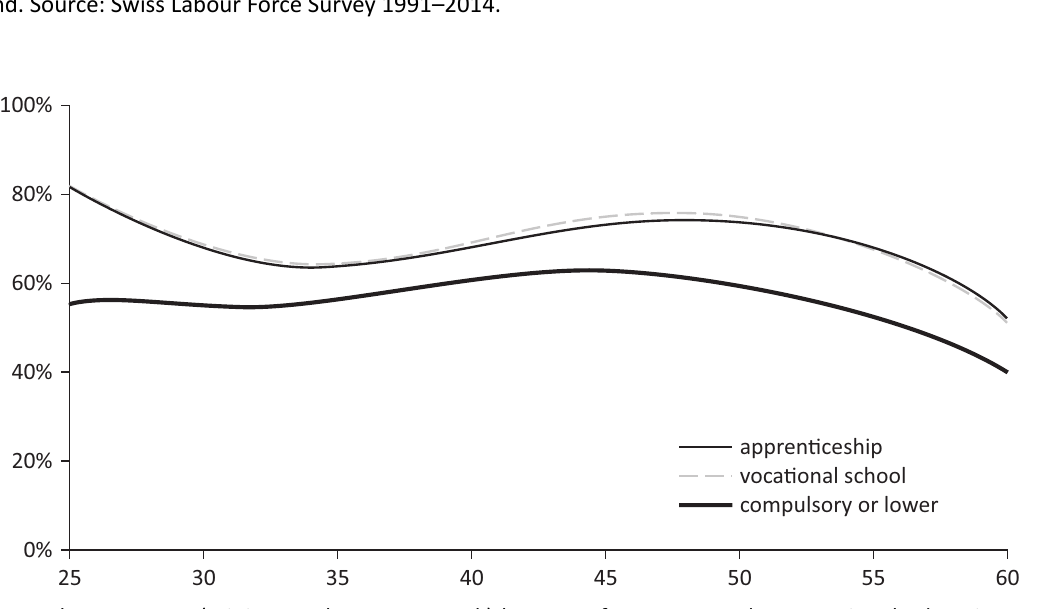
Figure A5. Employment rate (minimun 8 hours per week) by type of upper-secondary vocational education. Women— Switzerland. Source: Swiss Labour Force Survey